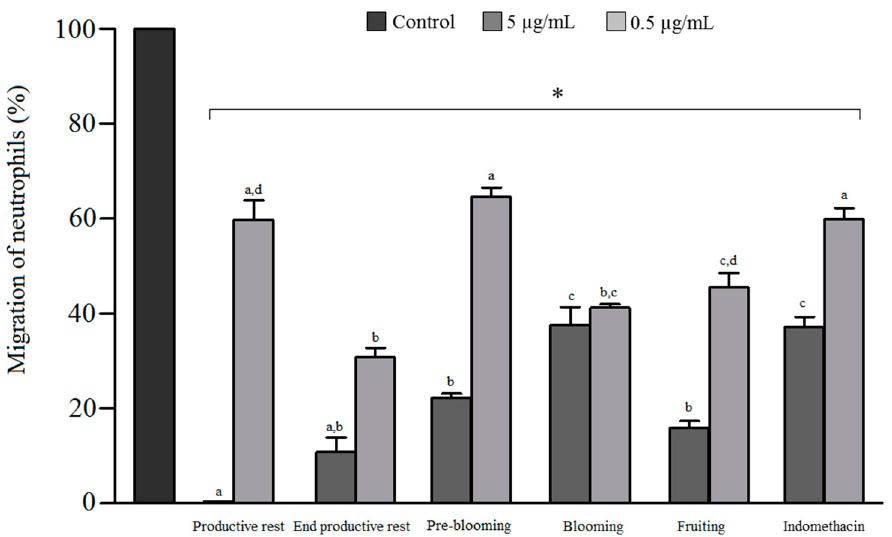
Figure 2. In vitro effect of the different essential oils of Nectandra megapotamica and indomethacin on neutrophil migration. * Significant inhibition at all tested concentrations compared with negative control. Different letters indicate a significant difference between samples at the same concentrations ( p < 0.05) (ANOVA, followed by Tukey’s test).